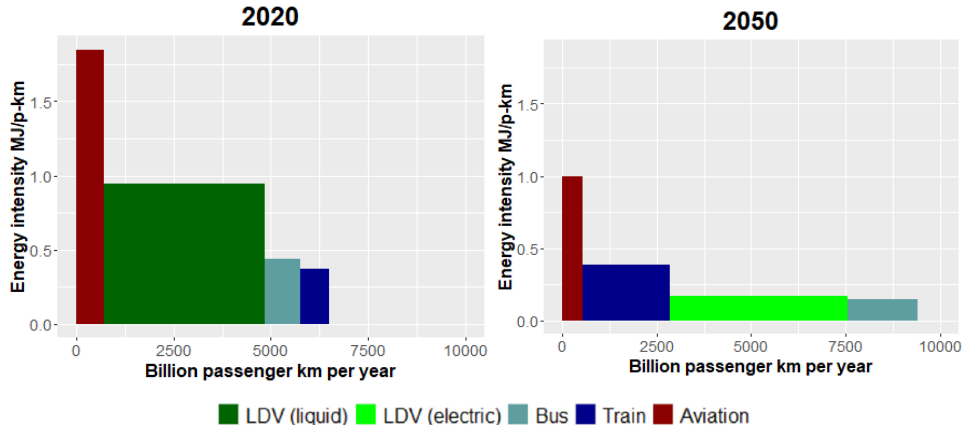
Figure 3. Decomposition of mobility for Western Europe region from ‘1.5C Total’ scenario [16]. The X -axis shows activity (distance travelled) and the Y -axis shows intensity. Each coloured bar represents one form of mobility service, with the area of the bar proportional to final energy for that service. The widths of the coloured bars represent the structure (share of activity for each form of service).